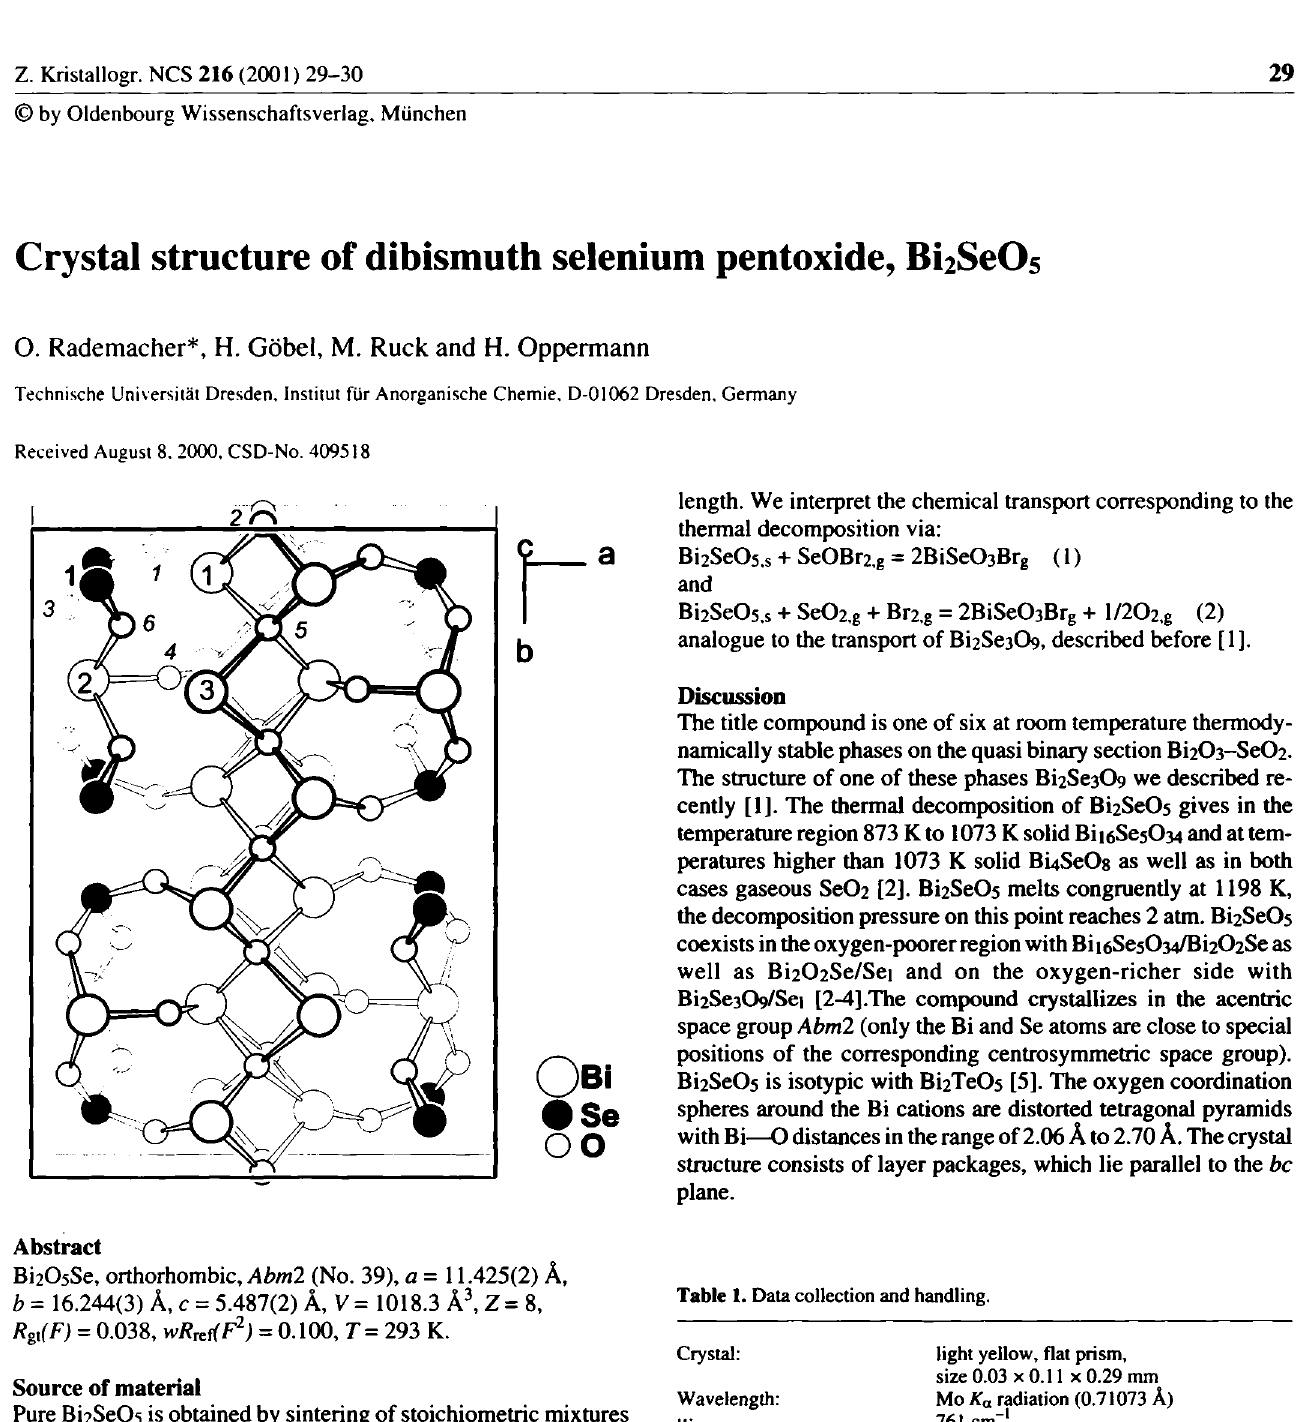
Table 1. Data collection and